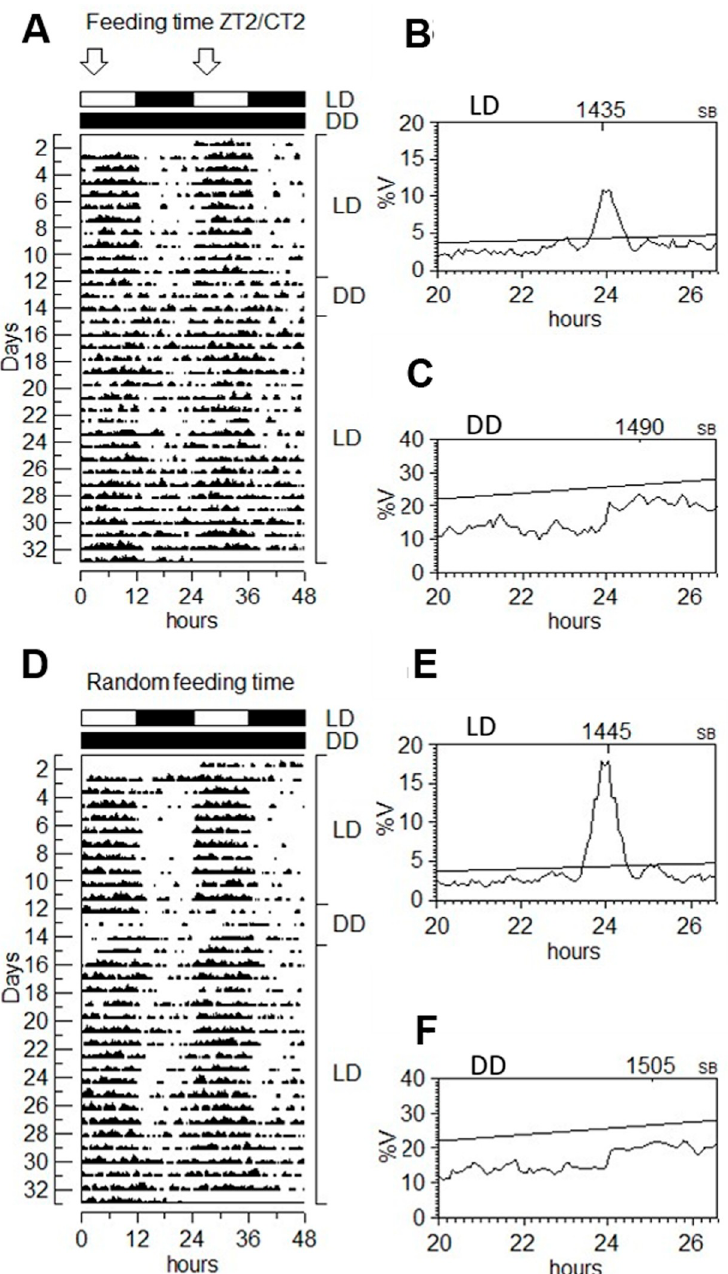
Fig 4. Diurnal locomotor activity of turbot in LD-DD-LD lighting conditions. A, D) Representative actograms of turbot swimming activity. Recording activity during 33 days is represented by double plot of two consecutive days. The white and black bars above the actograms indicate light and dark periods. The arrows above the white bar indicate the time where food is delivered. Fish were kept in LD and fed at ZT2 for 33 days (A), or randomly fed during the light phase (D). From day 12 to 14 fish were in DD and then returned to LD. Fishes showed daily periodicity in LD (B, E), but not in DD (C, D). Turbot displayed its activity mainly during the light